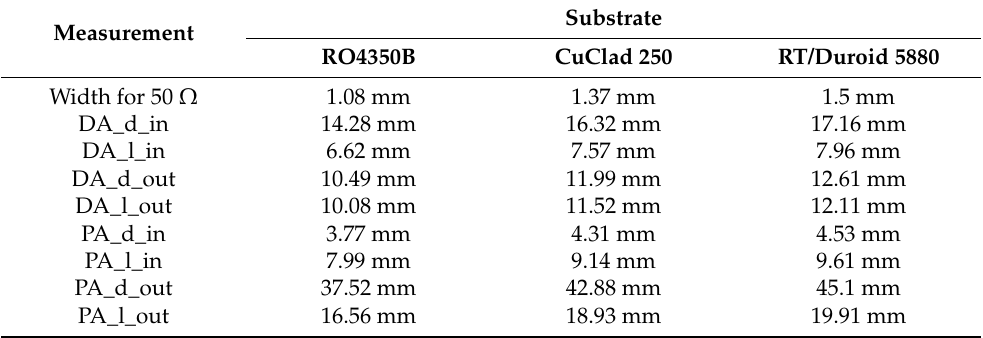
Table 2. Dimensions for microstrip lines for matching networks considering three substrates.